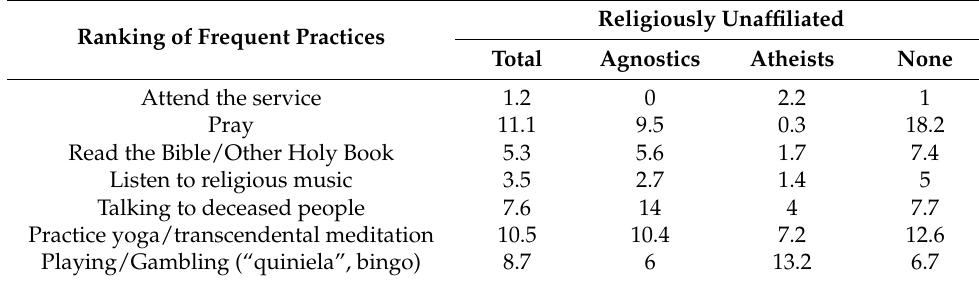
Table 2. Ranking of frequent practices 5 of the religiously unaffiliated (in %). Ranking of Frequent Practices